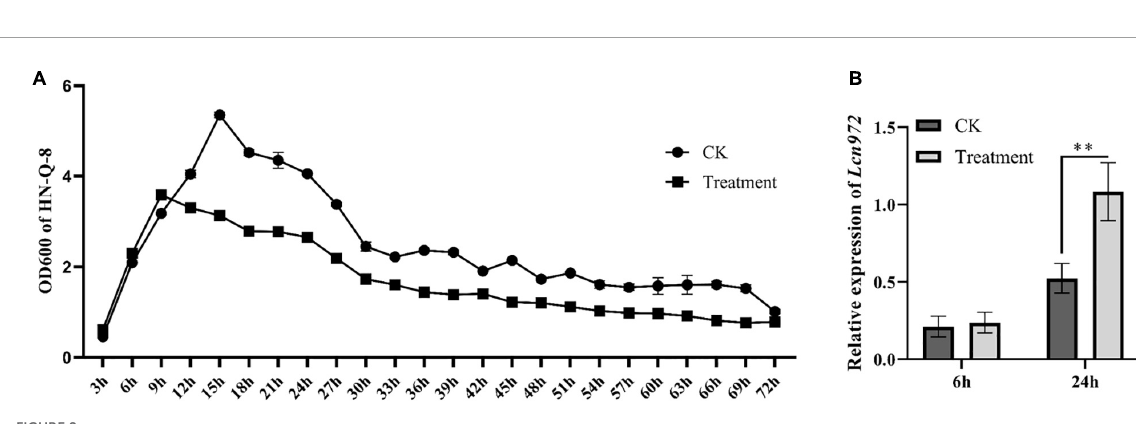
FIGURE8 Effect of Streptomyces scabies on the expression of Lcn972. (A) Growth curve of Bacillus velezensis HN-Q-8; (B) relative expression of Lcn972. CK: B. velezensis HN-Q-8 added to Gauze’s synthetic broth medium; Treatment: B. velezensis HN-Q-8 added to cell-free culture medium of S. scabies HP4. ∗∗ P < 0.01, one-way ANOVA, followed by Dunnet post-test, compared to